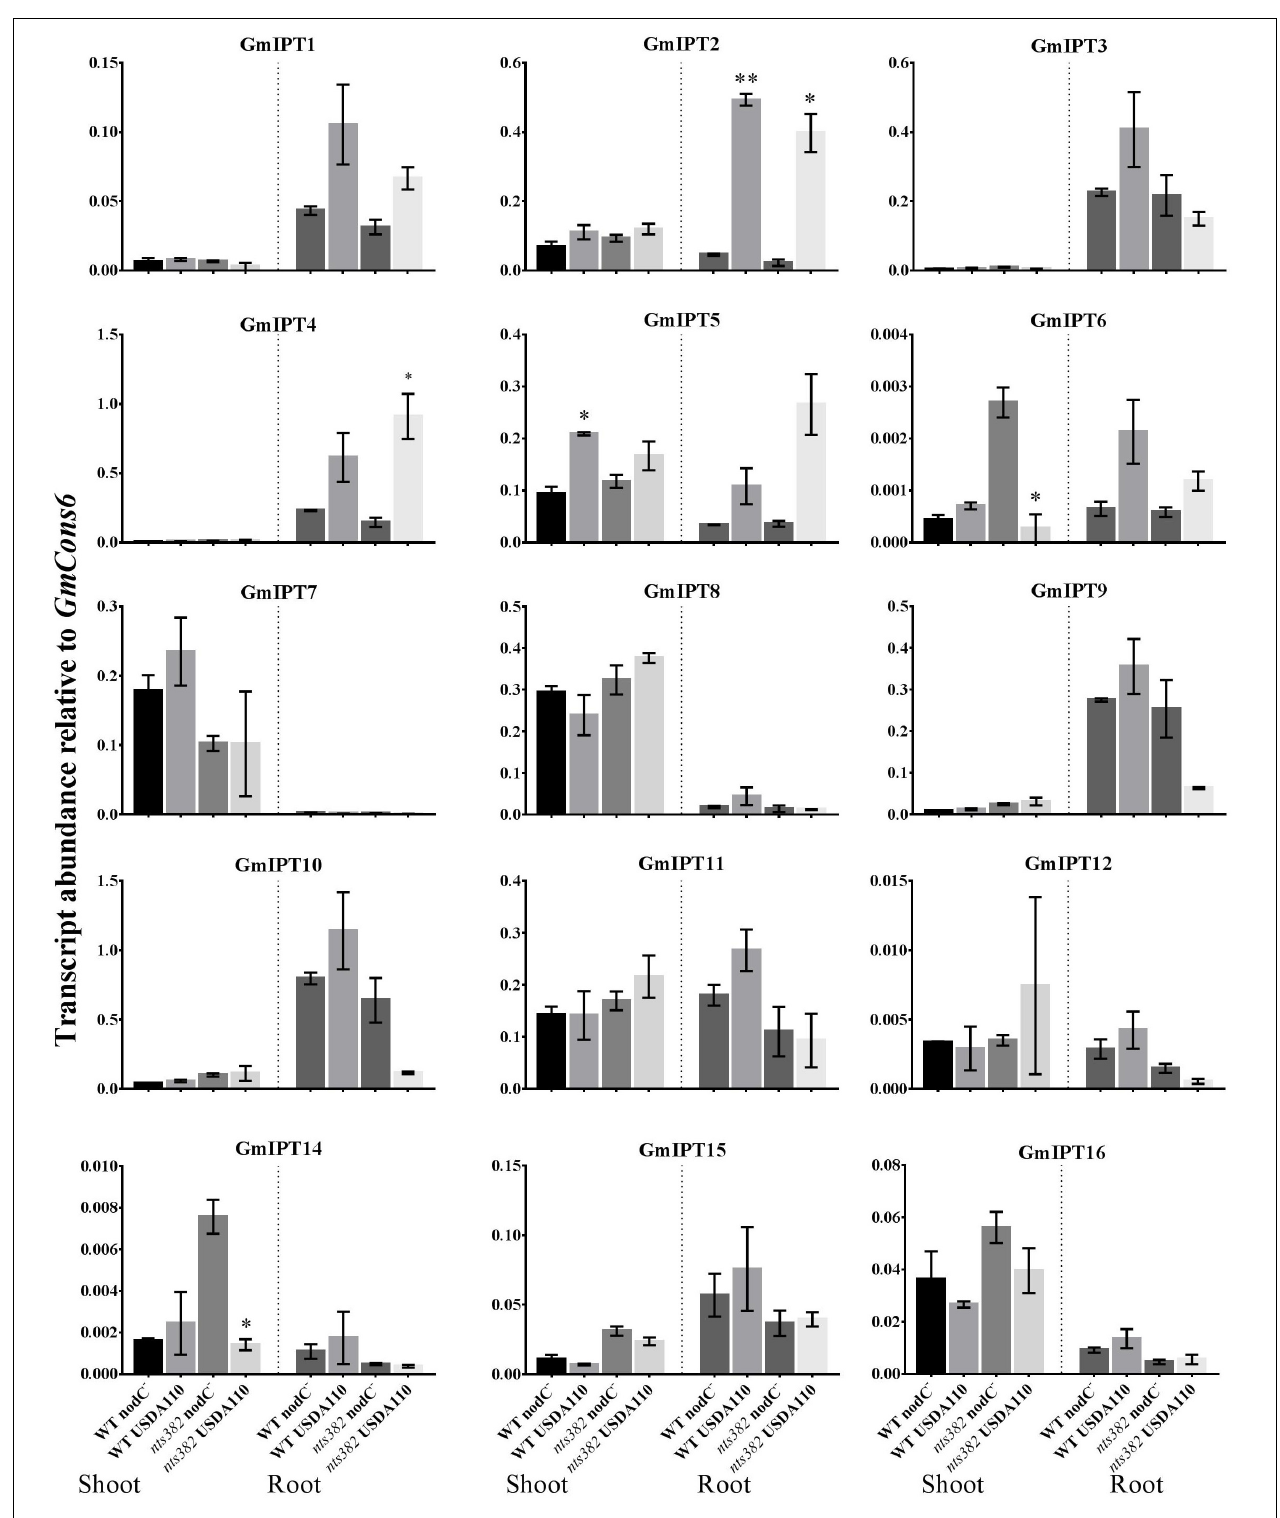
FIGURE 4 | Expression of soybean IPT genes in the shoot and roots following inoculation with B. diazoefficiens . Two-week old wild-type Bragg (WT) and GmNARK mutant ( nts382 ) plants were inoculated with B. diazoefficiens USDA110 or its isogenic and incompatible nodC − mutant. The first trifoliate leaf and total root were harvested 10 days after inoculation. Expression levels are relative to the housekeeping gene GmCons6 . Bars represent mean ± SEM of two biological replicates ( n = 6 plants per replicate). Asterisks show significant differences in expression (Student’s t -test, ∗∗ P ≤ 0.01, ∗ P ≤ 0.05).